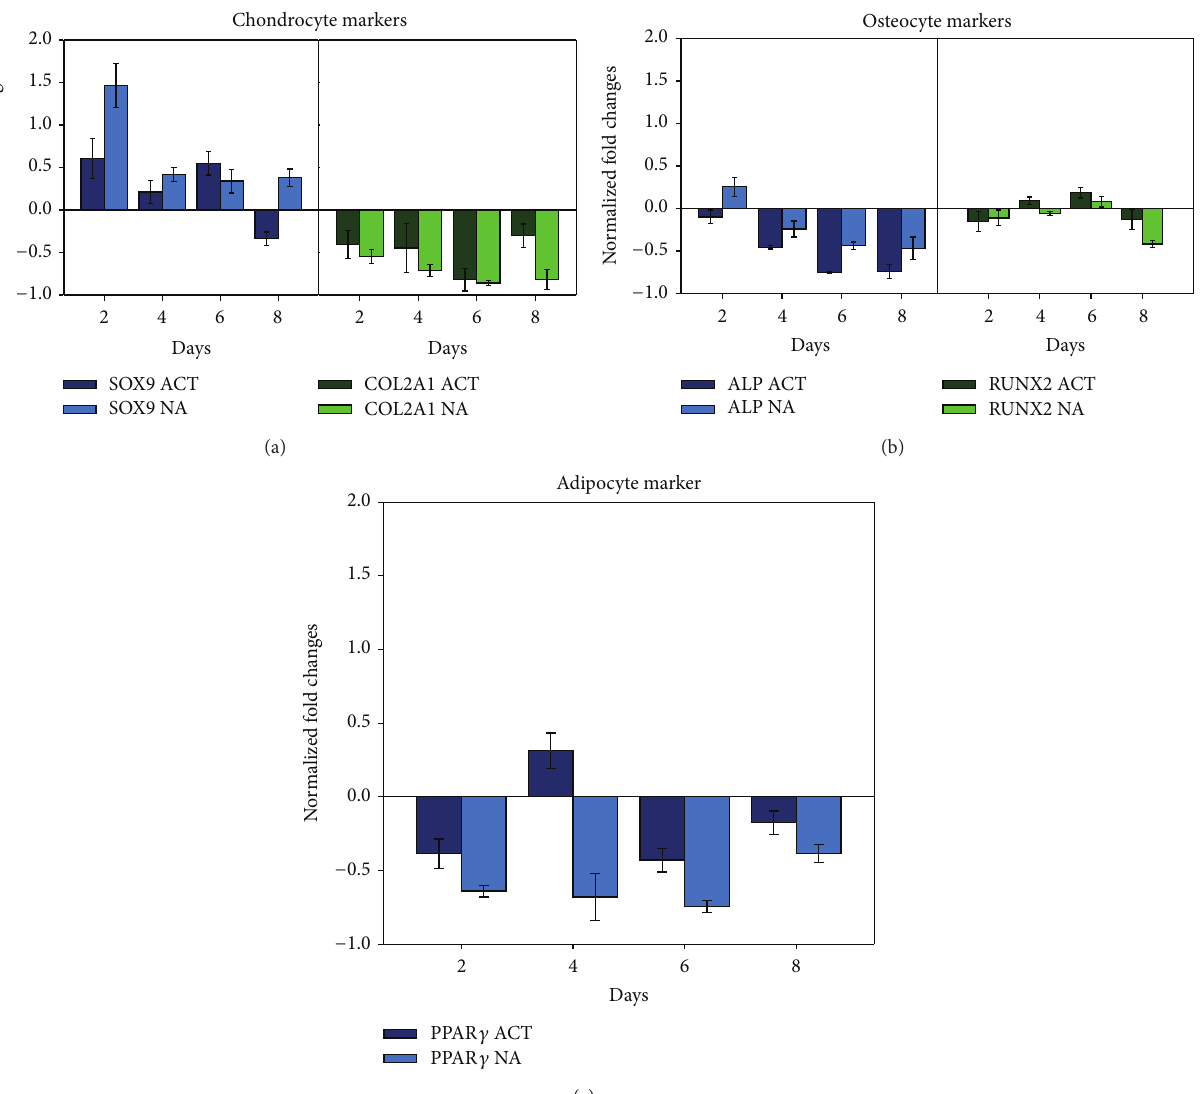
Figure 5: Gene expression levels of various markers specific to chondrocyte (a), osteocyte (b), and adipocyte (c) in hMSC cultured with 15% activated (ACT) and 15% nonactivated PRC (NA). SOX-9 expression was significantly increased at earlier time points in the nonactivated PRC group ( ∗ 𝑃 ≤ 0.05 ). Gene expression was measured at each time point using the QuantiGenePlex 2.0 assay